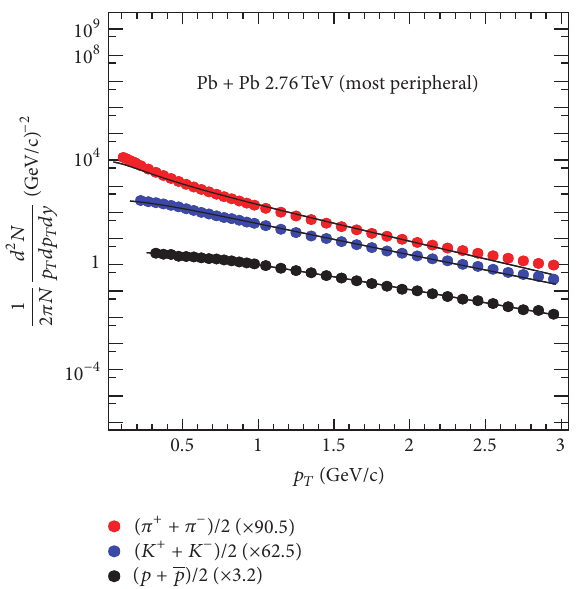
Figure 17: Fitting of invariant 𝑝 𝑇 spectra with Tsallis distribution including radial flow using (8) for (𝜋 + + 𝜋 − )/2 [19, 20], (𝐾 + + 𝐾 − )/2 [19, 20], and (𝑝 + 𝑝)/2 [19, 20] in most peripheral Pb + Pb collisions at √𝑠 NN = 2.76 TeV; symbols represent the data points and the line is the fit function.